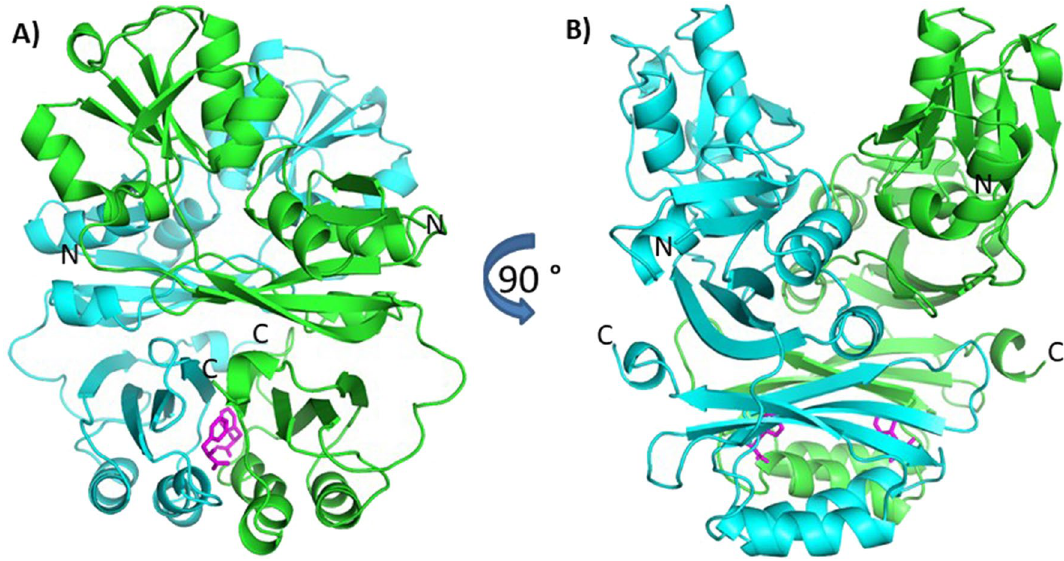
Figure 6. Homodimer of GqqA with labelled N- and C-termini. Monomers are shown in cyan and green. Within the C-terminal ACT domain a four-stranded anti-parallel β-sheet of one monomer with its symmetry